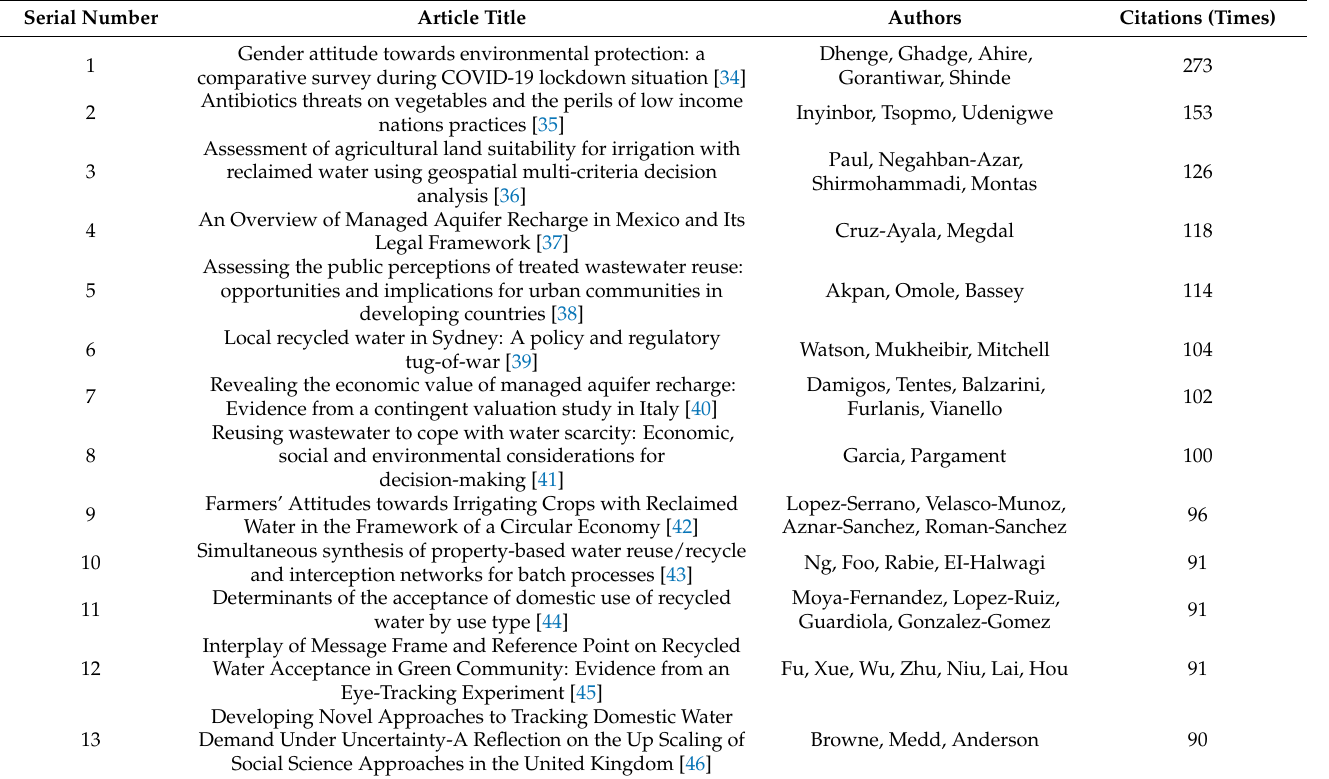
Table 6. Highly cited articles in WOS from 2004 to 2022.